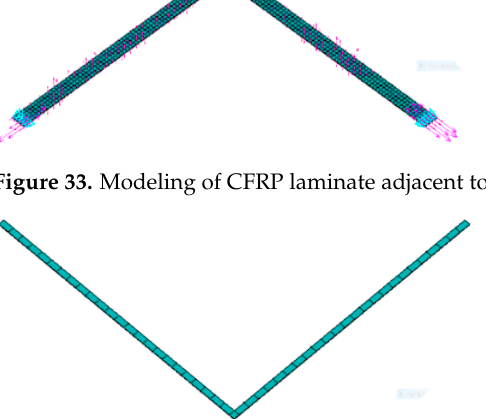
Figure 34. Modeling of CFRP laminate at middle span (field laminate).